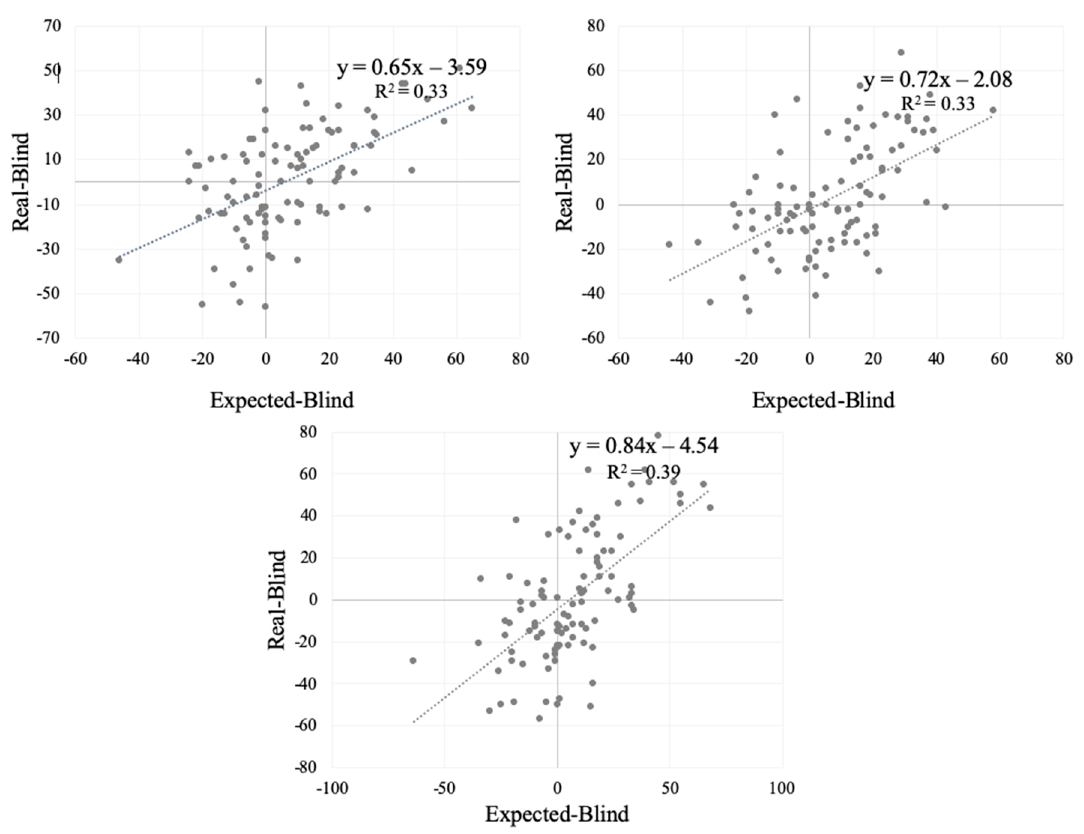
Figure 3. Effect of expectancy disconfirmation for B 0 , B 2 , and B 3 samples. Linear regression plot of E–B vs. R–B scores.